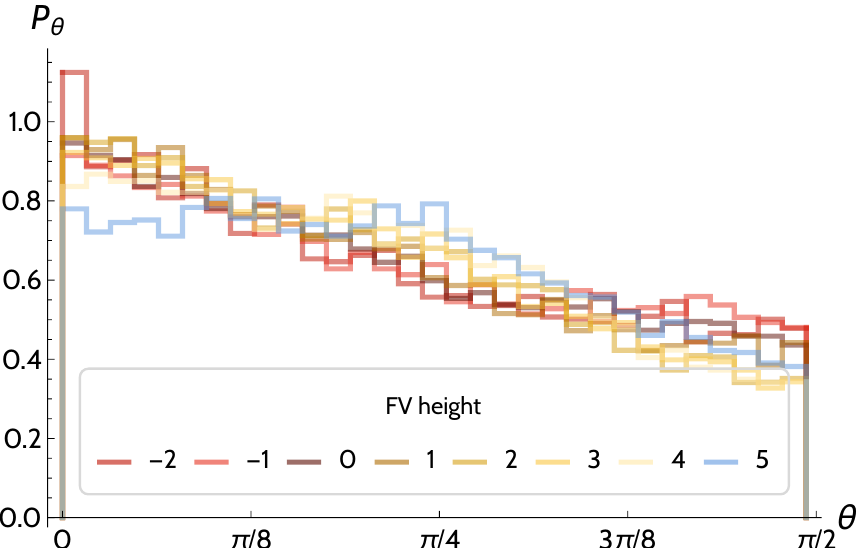
Figure 7. Exit angle distribution with respect to direction of the lowest eigenvalue for the instanton path of the most probable decay channel in each generated